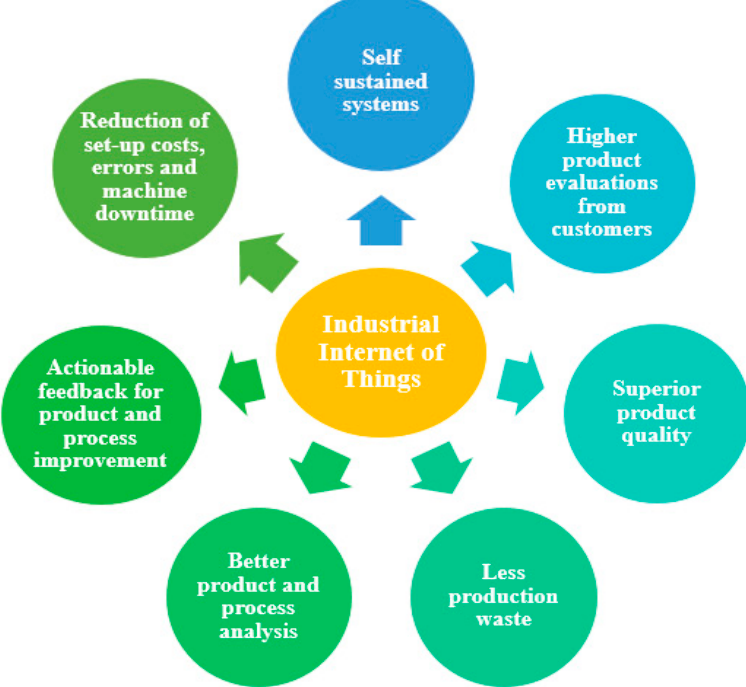
Figure 2. Opportunities for Industrial Internet of Things.